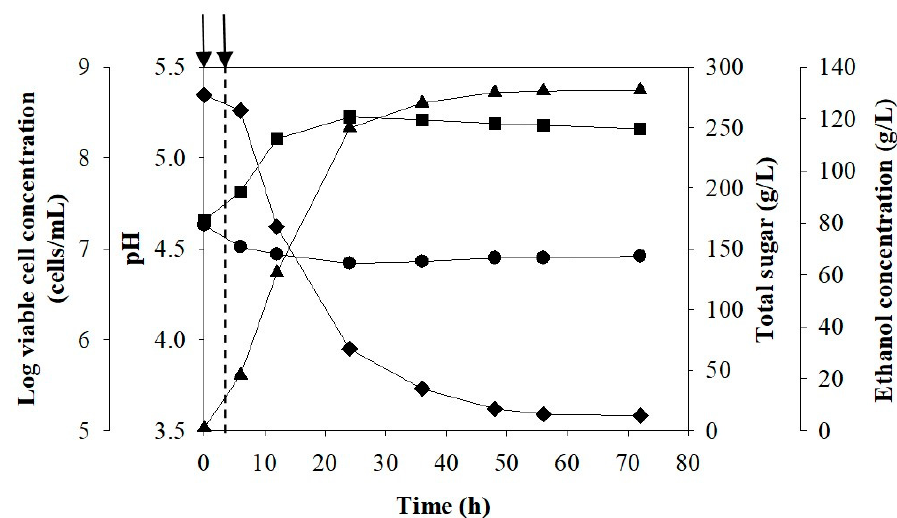
Figure 5. Fermentation profiles during ethanol production by S. cerevisiae NP01 from the sweet sorghum juice supplemented with yeast extract (3 g/L), DSY (4 g/L), and glycine (5 g/L) at an agitation rate, 200 rpm; aeration rate, 2.5 vvm, and aeration time, 4 h. The arrows indicate the start and the end of aeration. ( = log viable cells, = pH, = total sugar, = ethanol).